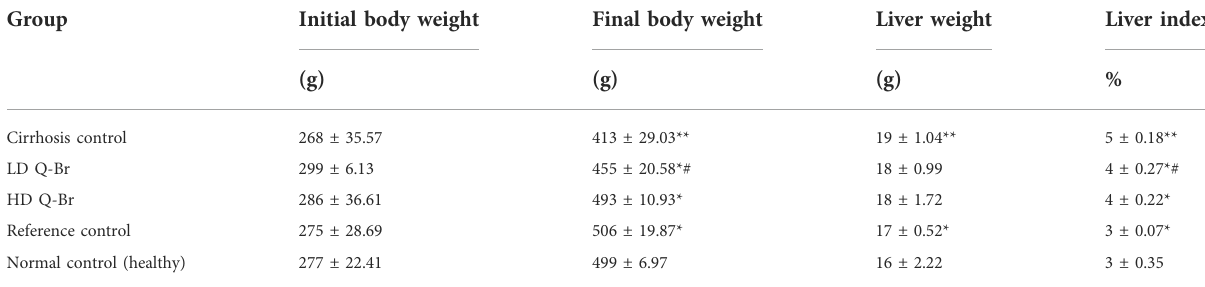
TABLE 1 Effect of Q-Br treatment on the fi nal body weight and liver index of the rats after 15 weeks of sub-chronic liver injury induced by TAA.